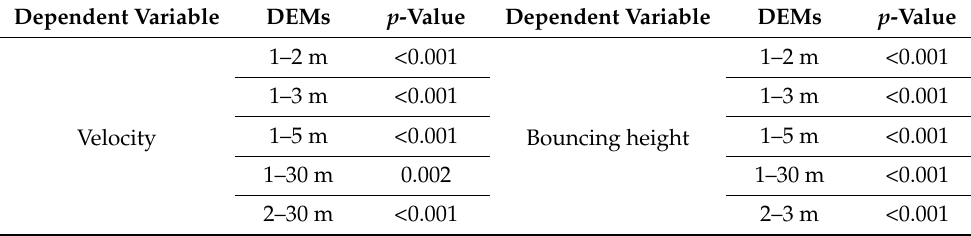
Table 3. Dunn’s (Post Hoc) test results.